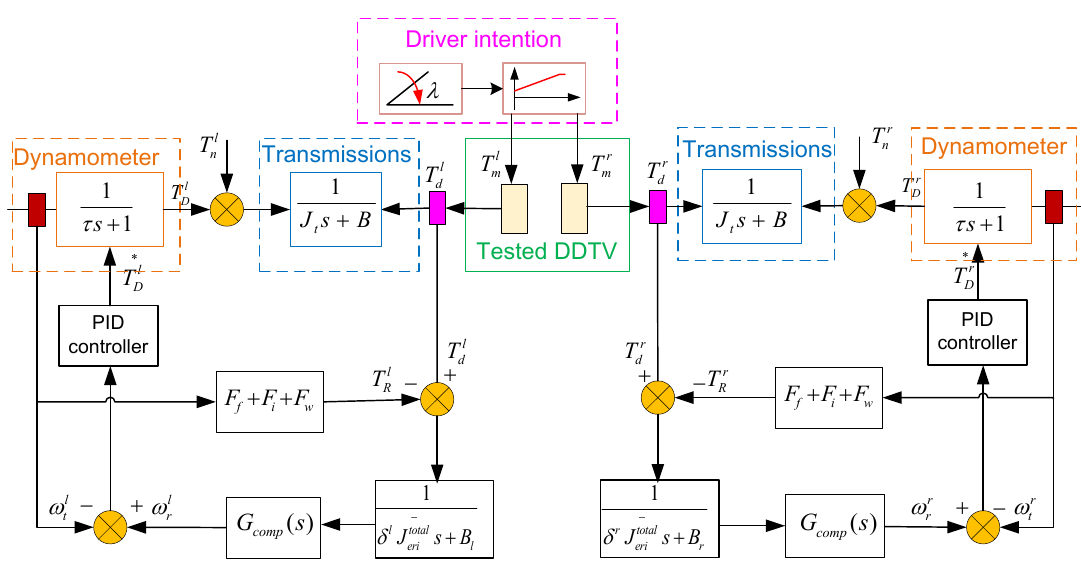
Figure 8. The structure of control strategy of the test bench.